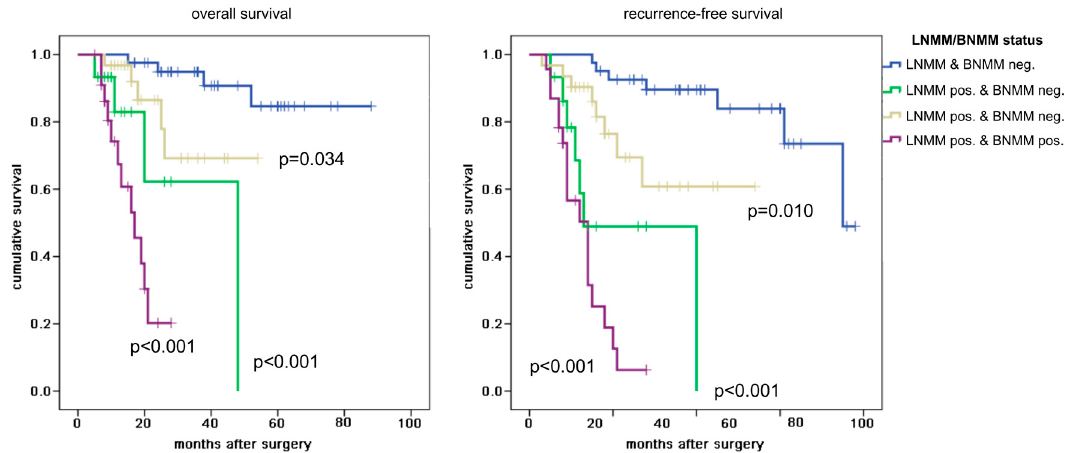
Figure 2. Kaplan–Meier curves of the lymph node and bone marrow micrometastases status for overall and recurrence-free survival. LNMM / BNMM status: lymph node and bone marrow metastases status (LNMM and BNMM negative, LNMM positive and BNMM negative, LNMM negative and BNMM positive, LNMM and BNMM positive); log-rank test was performed against LNMM and BNMM negative. The crosses mark censored patients. p value < 0.05 is considered significant.